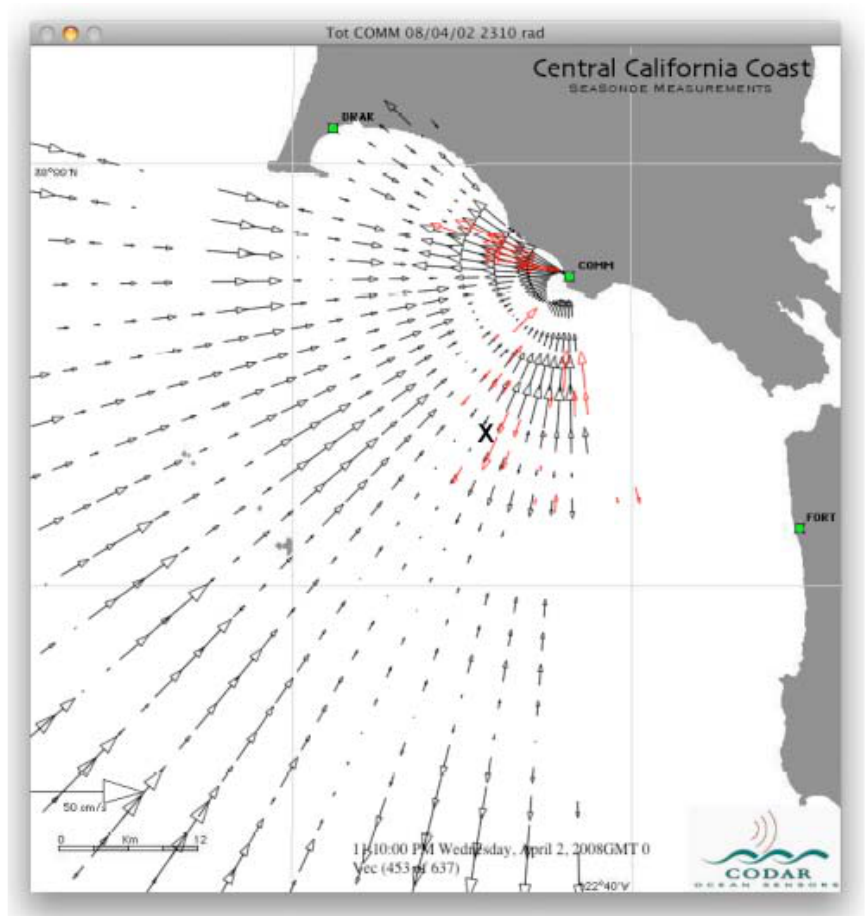
Figure 9. A comparison map of radial velocities measured by COMM (Black) and drifters (Red) on April 02, 2008 23:10. Time series of radial velocities at the point shown marked X are plotted in Figure 10.